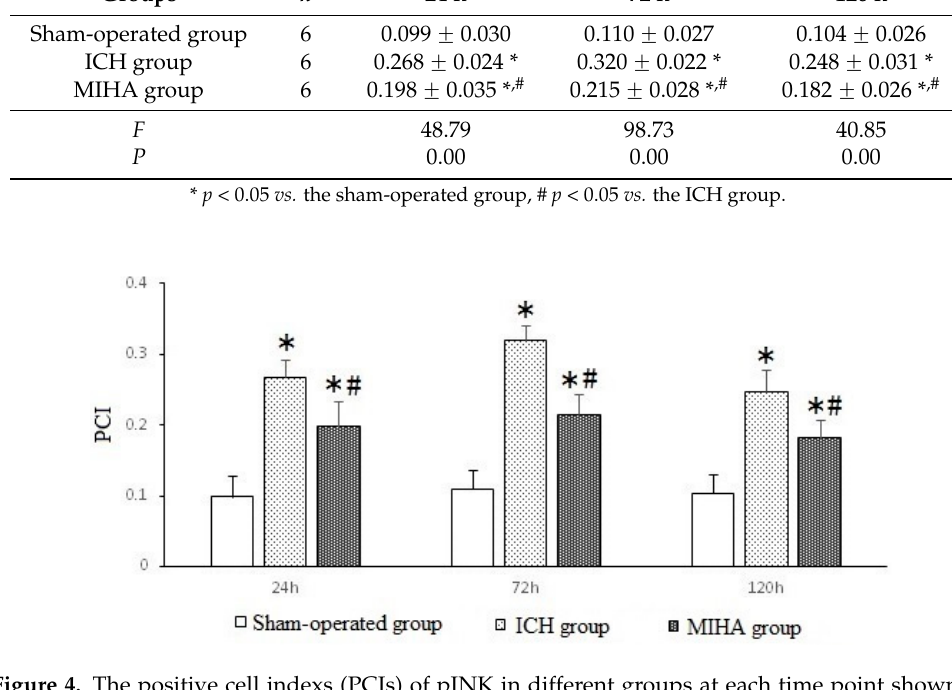
Figure 4. The positive cell indexs (PCIs) of pJNK in different groups at each time point shown by immunohistochemical assay. * p < 0.05 vs. the sham-operated group, # p < 0.05 vs. the ICH group.